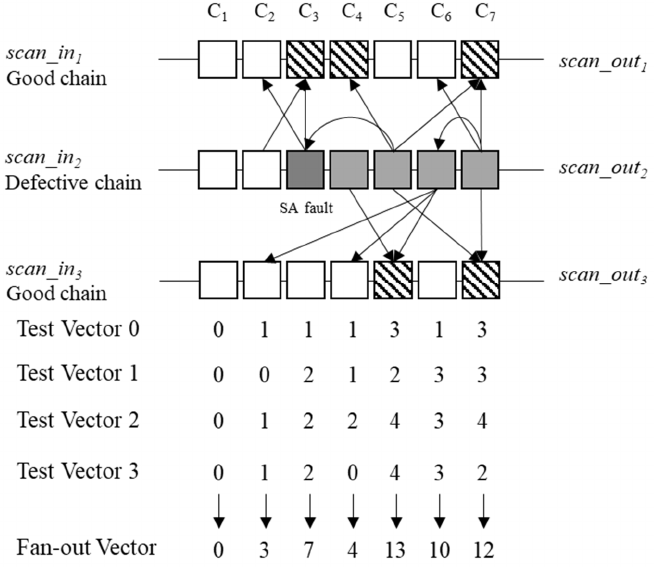
Figure 7. Example of the fan ‐ out filter.